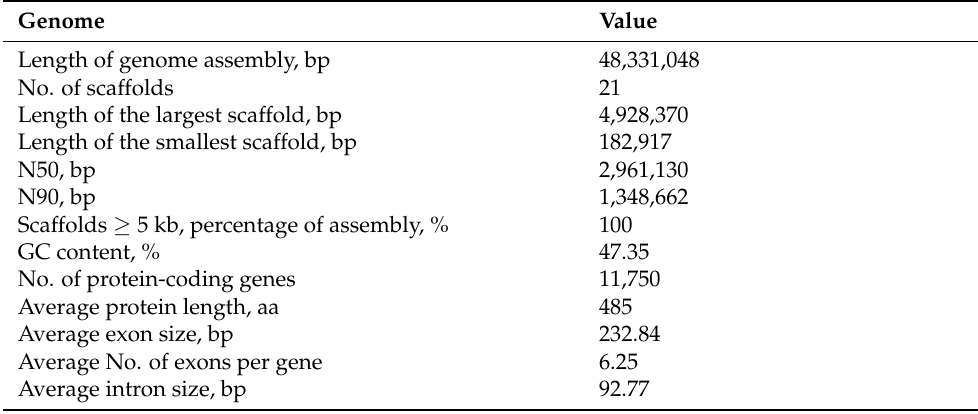
Table 1. Summary of the genome assembly and annotation of Stropharia rugosoannulata